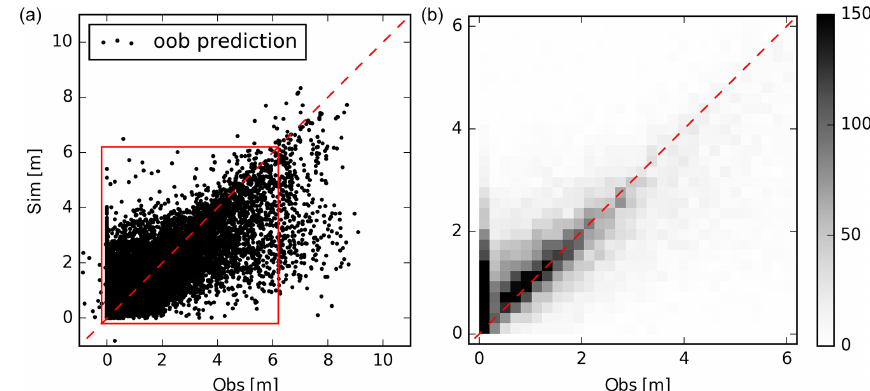
Figure 3. The RF accuracy assessment was performed based on the out-of-bag sample technique. The axes depict the simulated (Sim) and observed (Obs) depth to the shallow water table. Panel (a) displays a standard scatter plot containing ∼ 15000 well data points. The 1900 additional observations are excluded. Panel (b) shows a zoom-in (extent indicators in red in panel a ) and the data are visualized as a density scatter plot. The colour bar represents the number of data points in each square.